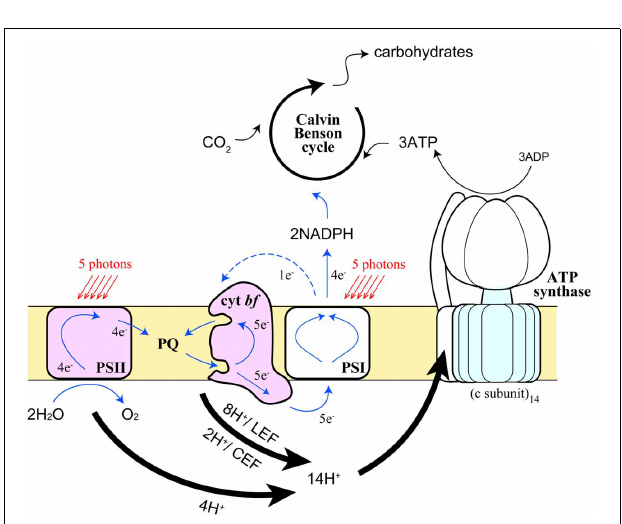
protonation of LHCSR3 ( red ; “H” denotes protonation) (E) in the acidified thylakoid lumen under HL conditions (D) . DCCD-binding to LHCSR3 ( yellow ; “D” denotes DCCD) inhibits the conversion of PSII-LHCII-LHCSR3 supercomplex from the light-harvesting state to the energy-dissipative state (F) . The crystal coordinates were obtained from the Protein Data Bank: PSII core, 3ARC; LHCII, 2NHW; and PSI-LHCI supercomplex, 2WSC.